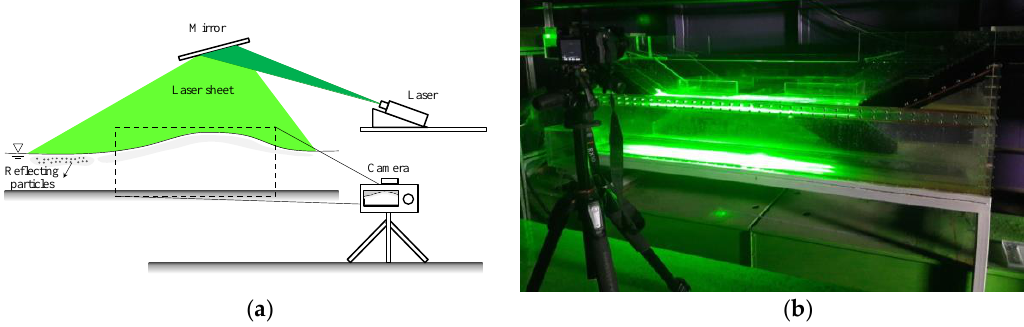
Figure 3. Inundation depth measurements using the laser image: ( a ) Outlines of water surface measurements using a laser; ( b ) Photo of water surface measurements.